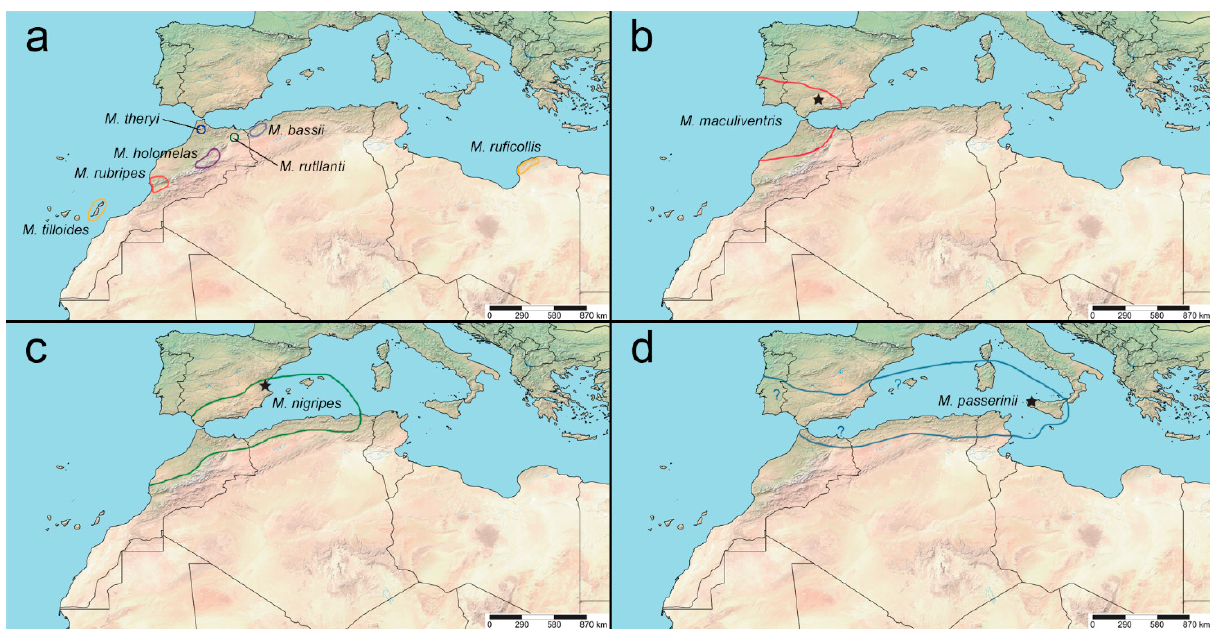
Figure 25. Distribution of Malacogaster Bassi, 1834. ( a ) M. bassii Lucas, 1870, M. holomelas Peyerimhoff, 1949, M. rubripes Peyerimhoff, 1949, M. ruficollis Dodero, 1925, M. rutllanti Pardo Alcaide, 1945, M. theryi Pic, 1951, and M. tilloides Wollaston, 1864; ( b ) M. maculiventris Reitter, 1894; ( c ) M. nigripes Schaufuss, 1867; ( d ) M. passerinii Bassi, 1834. Black stars ( b – d ) represent type localities; question marks ( d ) represent literature data not confirmed in this study.